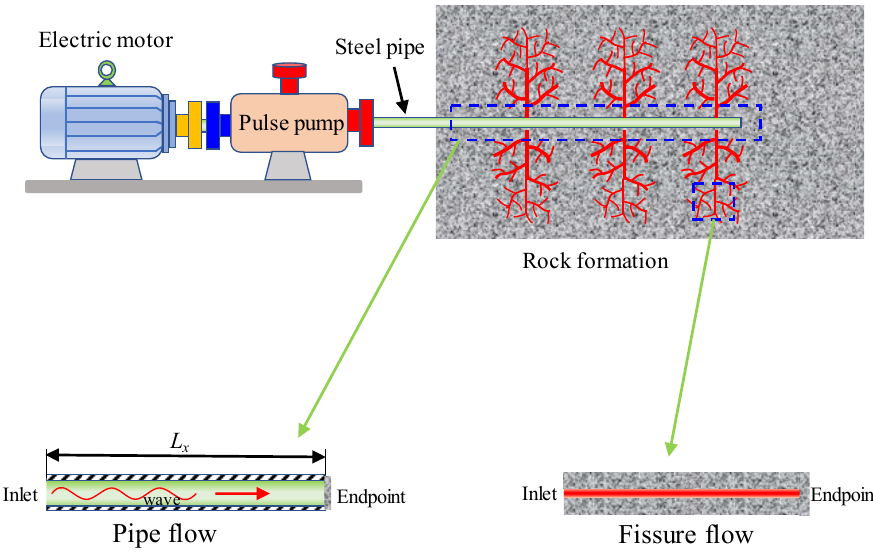
Figure 1. Diagram of the flow model in pipe and fissures during PHF; the upper part is the schematics of PHF and fissure networks, and the lower part is the local enlargement of pipe and fissure, whose length is L x and width is d . Pulse pressure wave is applied by the pulse pump.